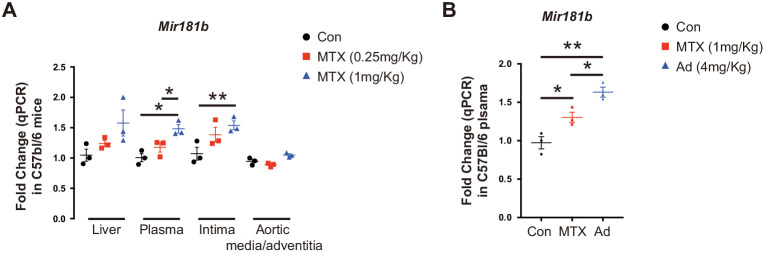
MTX and Ad increase Mir181b expression in the circulation and tissues.(A) Real-time qPCR analysis of Mir181b expression in plasma, liver, intimal ECs, and aortic media from C57BL/6J mice that were tail vein injected with vehicle or MTX (0.25 mg/kg or 1 mg/kg) or (B) MTX or Ad for 3 hr. (A–B), n = 3 mice per group. *p<0.05, **p<0.01. All values represent mean ± SEM.